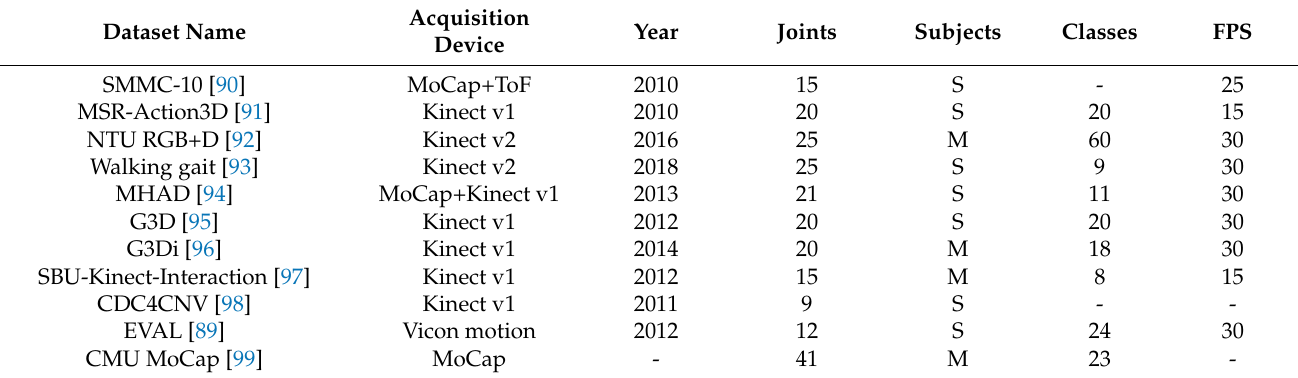
Table 4. Previously developed depth datasets for human